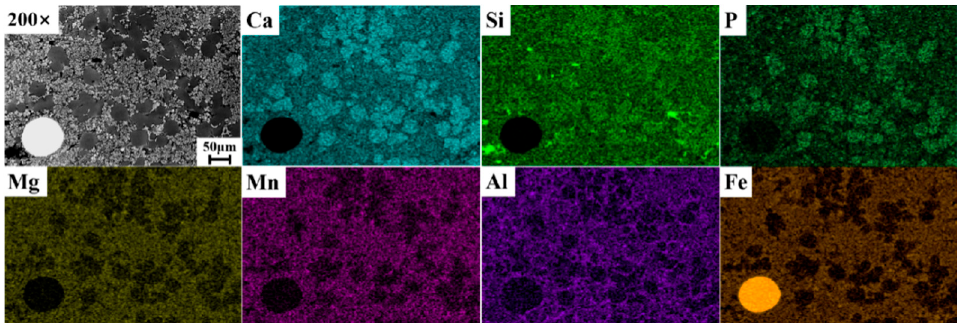
Figure 5. Images of dephosphorization slag by SEM-EDS at 1405 °C of ( a ) 200 times; ( b ) 500 times. Table 4. Element compositions of different phases in dephosphorization slag by SEM-EDS point analysis (mass%).